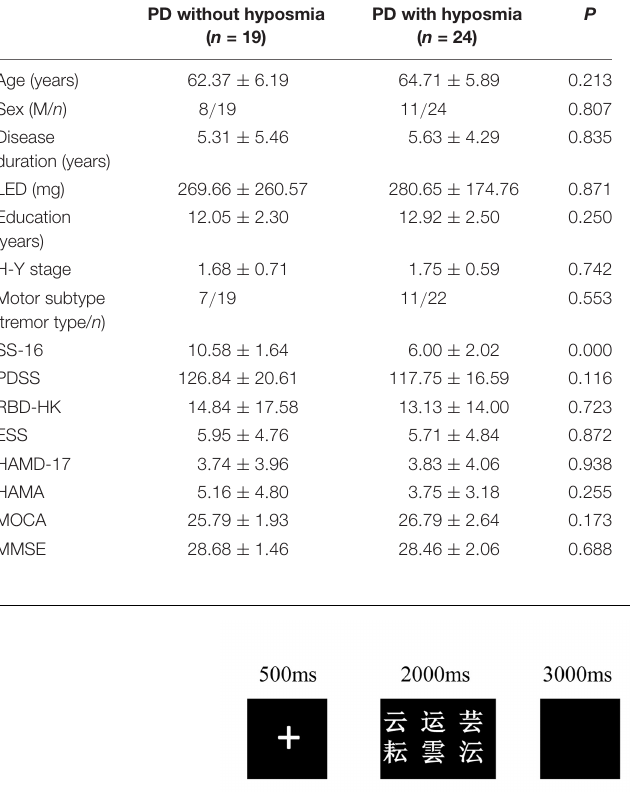
TABLE 1 | Demographics and clinical characteristics in PD with and without hyposmia groups (mean ± standard deviation).